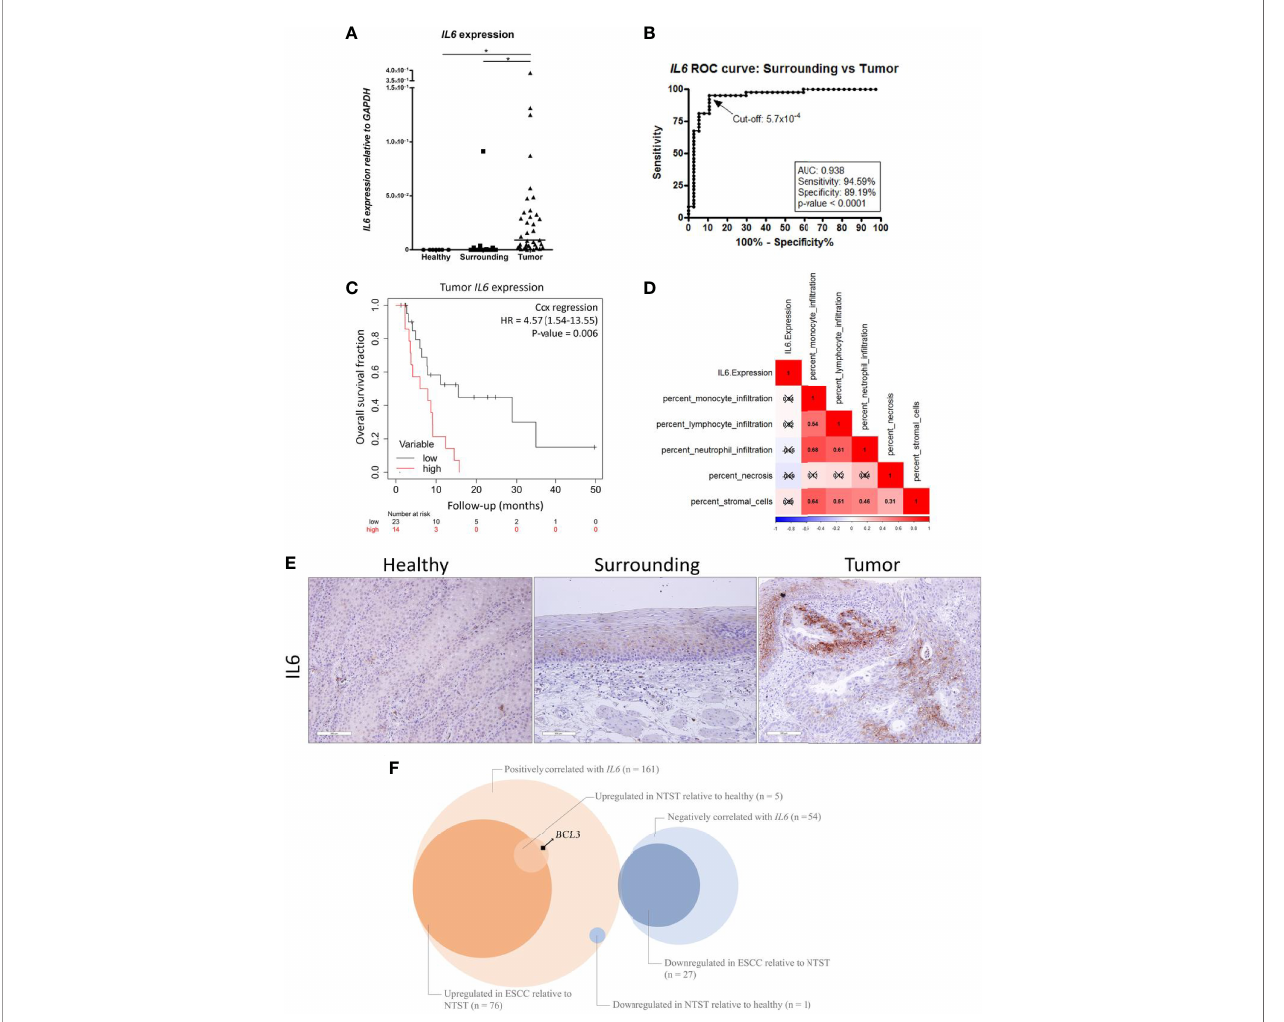
FIGURE 1 | IL6 dysregulation in ESCC. (A) Dot-plot representing IL6 mRNA expression normalized with GAPDH in esophageal mucosa from individuals without esophageal disorders (Healthy), histologically normal tumor-surrounding tissues from ESCC patients (Surrounding), and ESCC (Tumor). (B) Receiver Operating Characteristic (ROC) curve showing the sensitivity and speci fi city of IL6 mRNA expression normalized with GAPDH to distinguish Surrounding and Tumor samples from ESCC patients. IL6 expression cut-off of 5.7x10-4 showed the highest accuracy (93%), sensitivity (95%) and speci fi city (89%) (p < 0.0001). (C) Kaplan-Meier curve showing the overall survival of ESCC patients according to IL6 expression. High expression was de fi ned as ≥ 2.53x10 -2 GAPDH units, according to the best performing threshold. Tumor stage was used for adjustment. (D) Correlation matrix between IL6 expression and the percentage of different cellular populations in ESCC samples from the TCGA database. Red represents positive correlations, and blue represents inverse correlations. Boxes marked with an X depict non-signi fi cant correlations (p ≥ 0.05). (E) Representative FFPE slides from immunohistochemistry performed with IL6 antibody in esophageal mucosa from individuals without esophageal disorders (Healthy), histologically normal tumor-surrounding tissues from ESCC patients (Surrounding), and ESCC (Tumor). Sections were counterstained with Harris ’ hematoxylin. All images are shown in 20X magni fi cation and 300 µm scale bars are shown. (F) Venn diagram showing the number of genes whose mRNA expression was positively or negatively correlated with IL6 mRNA expression (q-value < 0.05) in ESCC samples from TCGA database, number of genes upregulated or downregulated in ESCC relative to non-tumor surrounding tissue (NSTS) (|fold-change| > 1.5 and FDR < 0.05) in our dataset, and number of genes upregulated or downregulated in NTST relative to healthy esophageal mucosa (|fold-change| > 1.5 and FDR < 0.05) in our dataset. BCL3 is highlighted as a gene whose mRNA expression was positively correlated with IL6 expression in ESCC, and that was found upregulated in NTST relative to the healthy esophagus. *p <